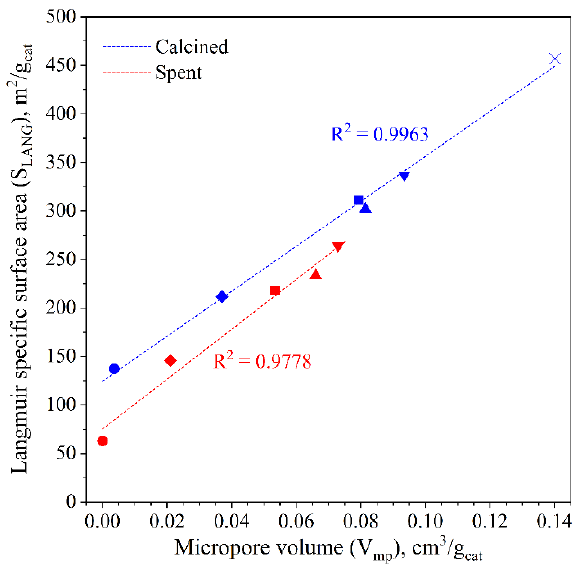
Figure 1. Relationship between the micropore volume and the specific surface area for calcined and spent catalysts (● CuZnZr; ♦ CZZ/FER OX 2:1; ■ CZZ/FER OX 1:2; ▲ CZZ/FER WI 1:2; ▼ CZZ- spent catalysts ( • CuZnZr; (cid:7) CZZ/FER OX 2:1; (cid:4) CZZ/FER OX 1:2; (cid:78) CZZ/FER WI 1:2; (cid:72) CZZ-FER FER MIX 1:2; ×Ferrierite). MIX 1:2; ×